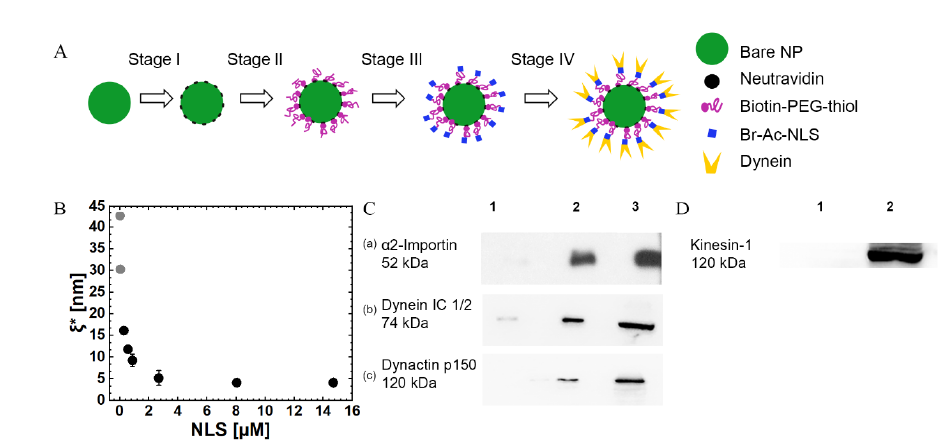
Figure 1. NP synthesis and characterization. ( A ) The NP synthesis process entails several consecutive steps, where, at each step, a single component is added. ( B ) Mean anchoring distance between neighboring PEG-NLSs ξ ∗ , against the concentration of TAMRA-NLS (shown as NLS ( x -axis) in the figure). The grey dots correspond to extrapolated values that were calculated from the fit of < N > vs. <NLS> (see Table 1, Supplementary Material Section S1, and Figure S2). Error bars indicate the standard deviations for three experiments. ( C ) Western blot (WB) analysis results, demonstrating the recruitment of α 2-importin (a); mammalian dynein motors (b); and dynactin to the NPs after incubation in a Hela cells extract. Group 1 refers to NPs coated with Biotin-PEG-thiol, group 2 refers to PEG-NLS coated NPs, and group 3 refers to Hela cell extracts without NPs. ( D ) WB analysis results, showing that kinesin-1 does not bind the PEG-NLS coated NP. Group 1 refers to PEG-NLS coated NPs, and group 2 refers to Hela cell extracts without NPs. Table 1. Summary of the systems studied and their basic properties: NLS and CE concentrations, estimated mean number (cid:104) N (cid:105) of PEG-NLS per NP, estimated mean anchoring distance ξ ∗ , and fractions of NPs performing distinct modes of motion. An identical cell extract was used in systems I and II, and another extract was used in systems III and IV. The bare NP mean radius is 20 Minus-end directed motion; detachment before arrival to the end. 0.64 0.72 Minus-end directed motion; NP stuck when MT-end is reached. 0.20 Minus-end directed motion + a single backward (plus-end) directed step, either during the motion or when the MT-end is reached.